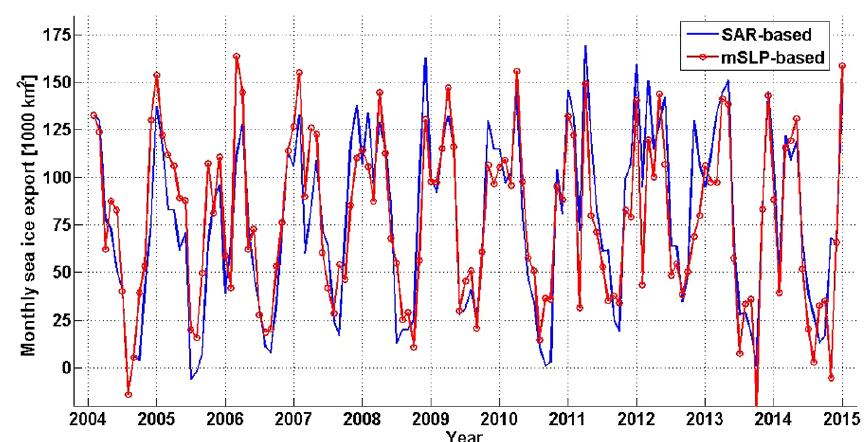
Figure 3. Monthly mean Fram Strait sea ice export. The SAR-based values are calculated from 3-day displacement vectors and corresponding sea ice concentration, while the other time series uses observed mean sea level pressure (mSLP) and the seasonal correction for a stronger East Greenland current during